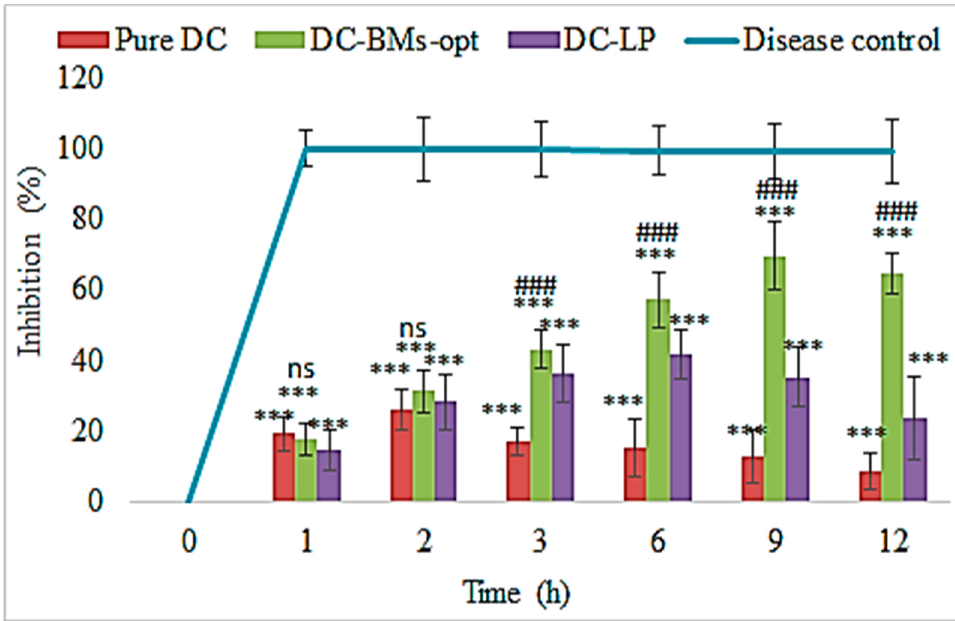
Figure 8. Anti-inflammatory activity of different treatment groups (pure diclofenac (DC), optimized diclofenac bilosomes (DC-BMs-opt), and diclofenac liposomes (DC-LP)) compared with disease control. Study performed with six rats (n = 6) in each group and result shown as mean ± SD. Statistical analysis performed between each group and p < 0.05 considered significant. *** highly significant to diabetic control; ### significant to pure DC and DC- LP; ns, non-significant to pure DC and DC-LP.